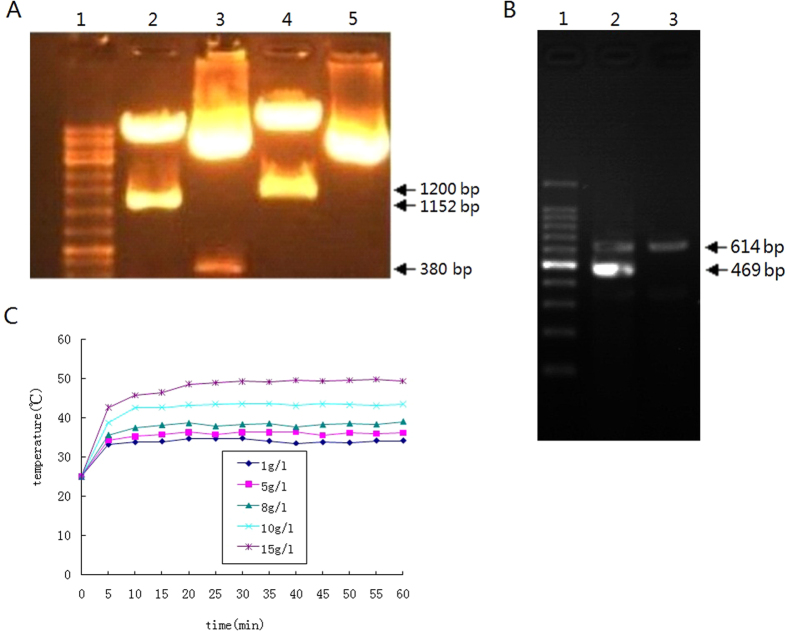
pHRE-HSV-TK was identified by restriction enzyme digestion and HSV-TK expression was examined after transfected into HepG2 cells.And temperature rising of PEI-MZF-NPs combined with pHRE-Egr1-HSV-TK under AMF was tested. (A) restriction enzyme digestion of pHRE-HSV-TK (lane 1: marker; lane 2: cut by MluI and NheI; lane 3: cut by BglII; lane 4: cut by EcoRI, XhoI; lane 5: without digestion by any restriction endonuclease). (B) HSV-TK expression in HepG2 cells transfected with pHRE-Egr1-HSV-TK (lane 1: Marker; lane 2: HepG2 cells transfected by pHRE-Egr1-HSV-TK group; lane 2: untransfected HepG2 cells group). (C) Heating curves of PEI-MZF-NPs/pHRE-Egr1-HSV-TK in vitro.